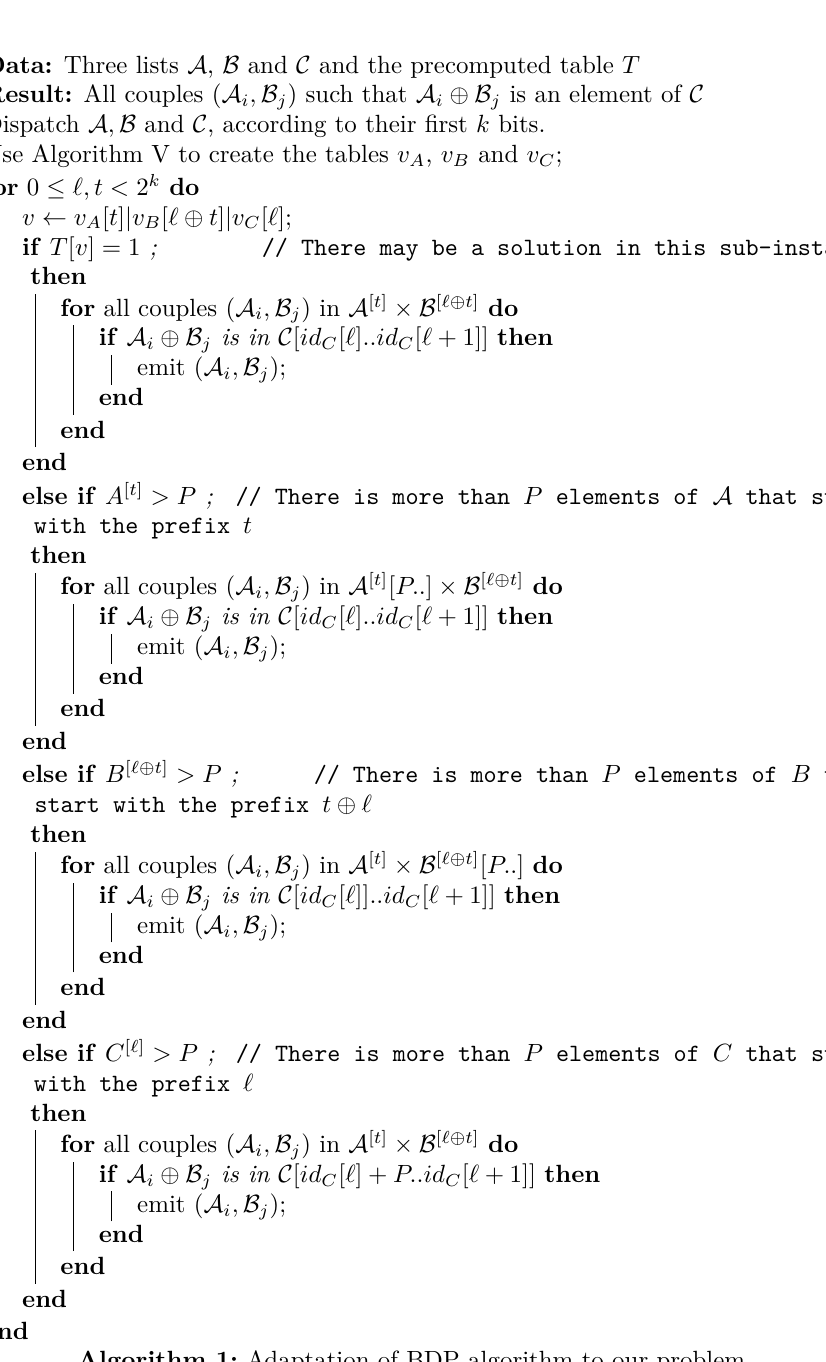
Algorithm 1: Adaptation of BDP algorithm to our